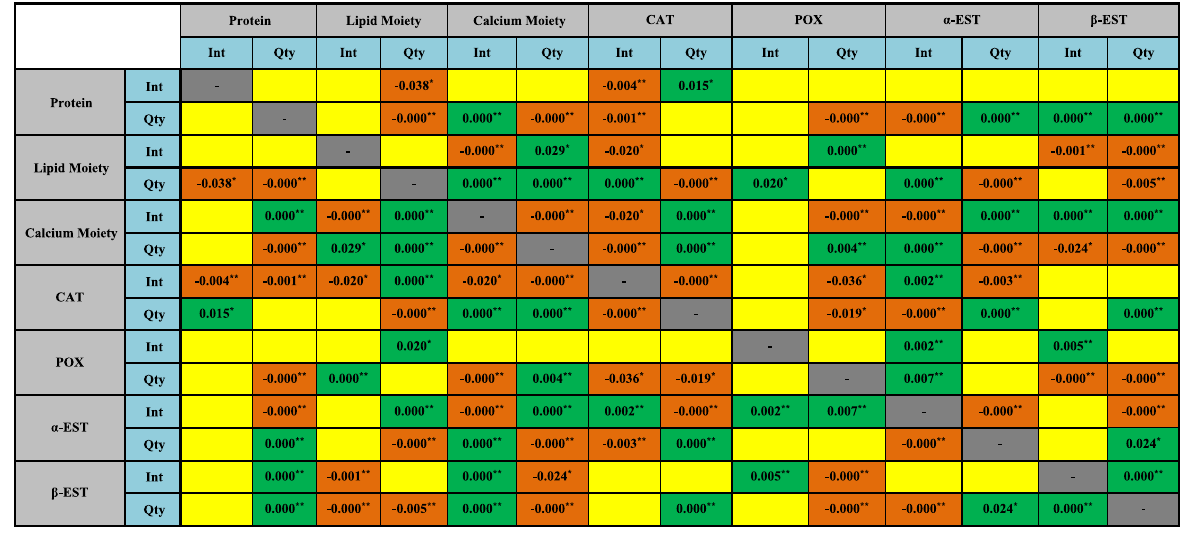
* Significant correlation at P<0.05; ** High significant correlation at P<0.01 Yellow cell indicates non-significant correlation, Orange cell indicates negative correlation, Green cell indicates positive